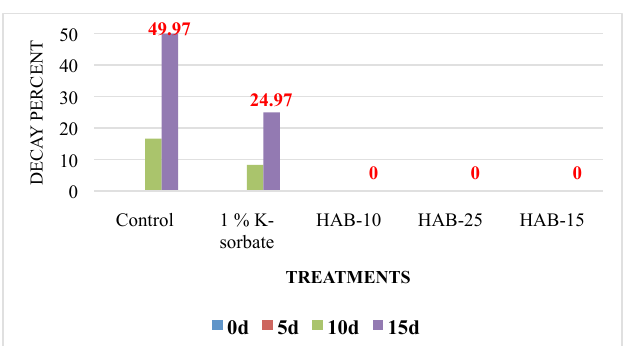
Fig. 2A: Effect of fluorescent Pseudomonas species on decay percent of tomato stored at 23±4 ºC with relative humidity in the range of 25%-70%. Fig.2B: Effect of fluorescent Pseudomonas species on decay percent of tomato stored at 23±4 ºC with relative humidity in the range of 25%-70%.